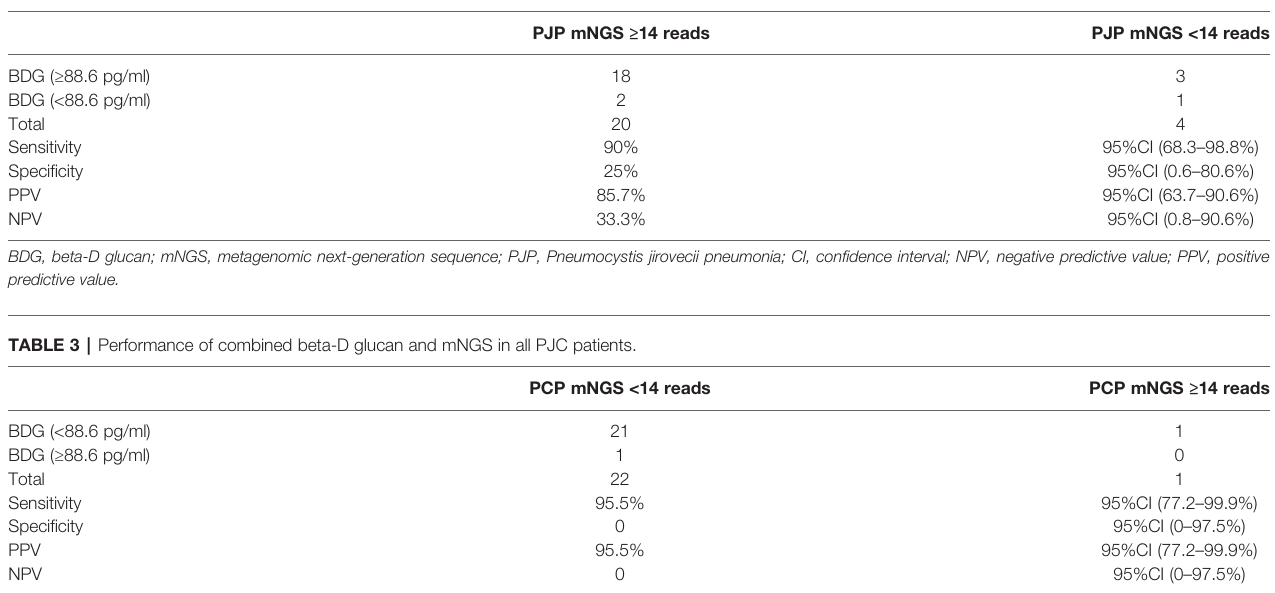
TABLE 2 | Performance of combined beta-D glucan and mNGS in all PJP patients. BDG ( ≥ 88.6 pg/ml)